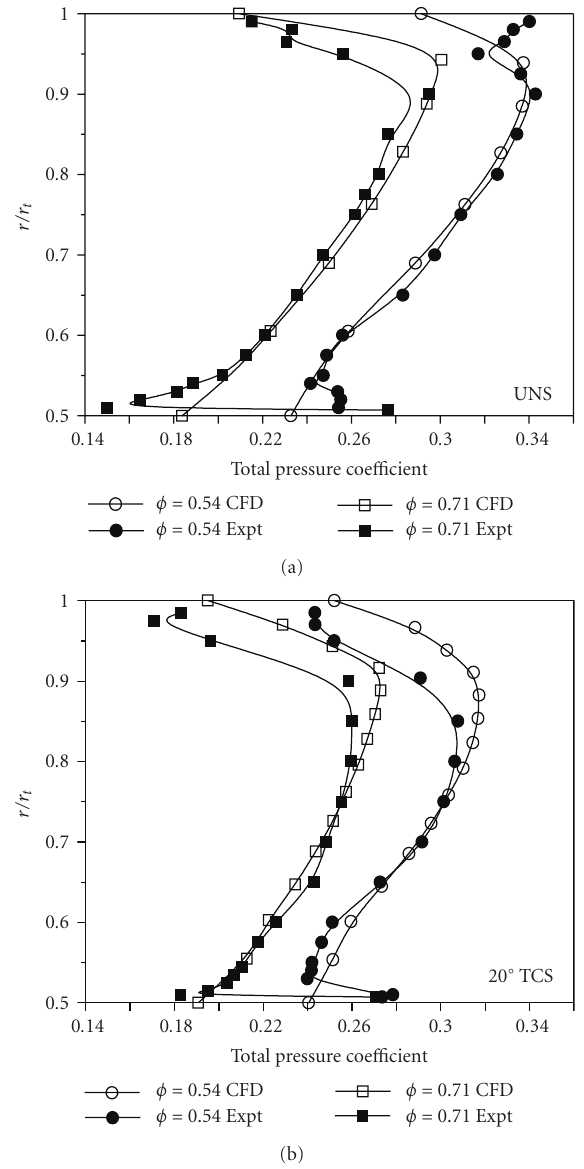
Figure 3: Variation of total pressure coe ffi cient at the rotor exit.